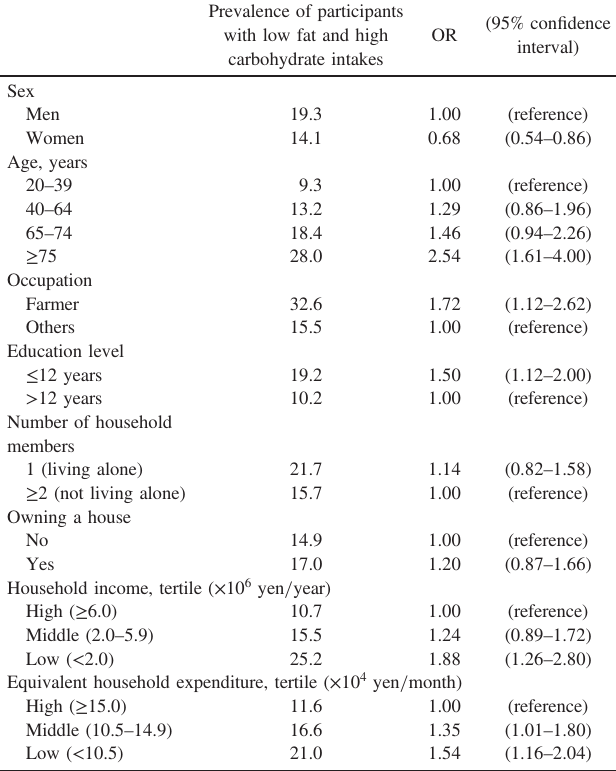
Table 5. Prevalence and odds ratio for high carbohydrate and low fat intakes a : NIPPON DATA2010 Prevalence of participants with low fat and high carbohydrate